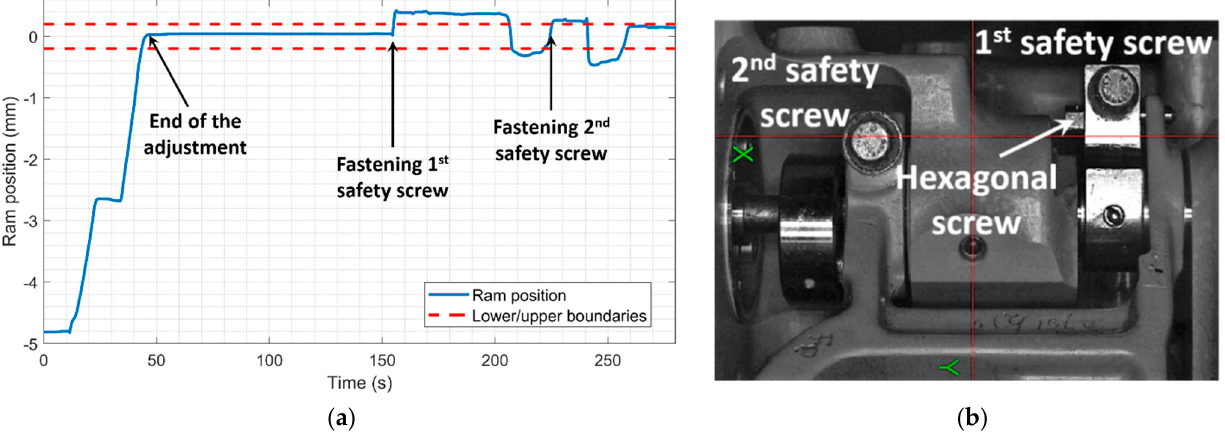
Figure 6. ( a ) Effect of the fastening of the two safety screws on the servo-actuator ram position; ( b ) Picture taken with the camera mounted on the UR10 tool flange of the hexagonal screw and the two safety screws connected to it.